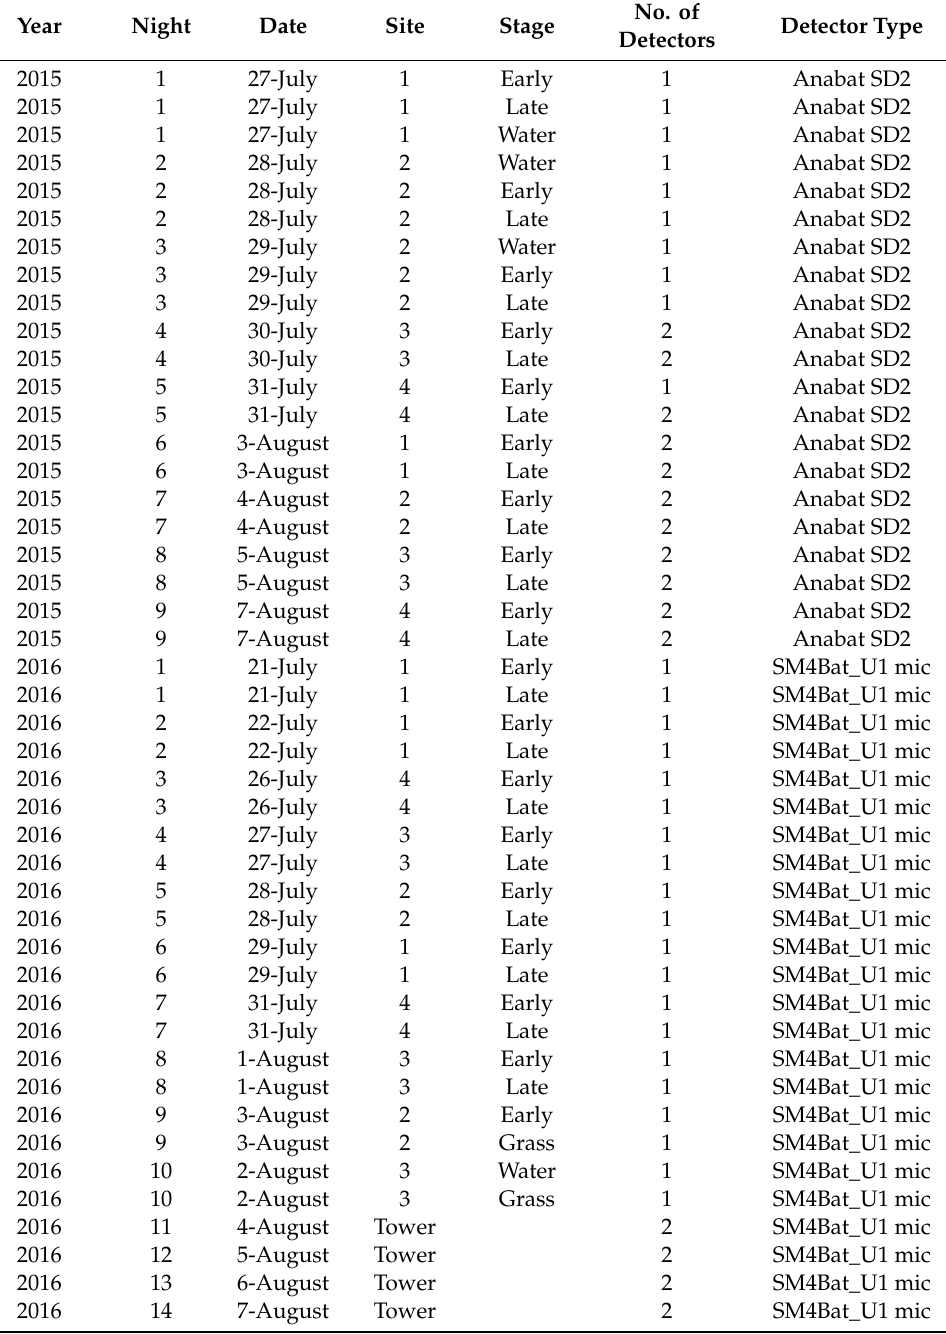
Table A1. Acoustic monitoring sampling details. Night = 18:00–06:00 h, Date = date of the start of the sampling night, Site = area of farm (see Figure 1), Stage = rice growth stage (see Methods), No. of detectors = number of ultrasonic detectors in each site and stage; the data from two detectors in one site and stage per night were averaged for analysis, Detector type = the model of ultrasonic detector and microphone